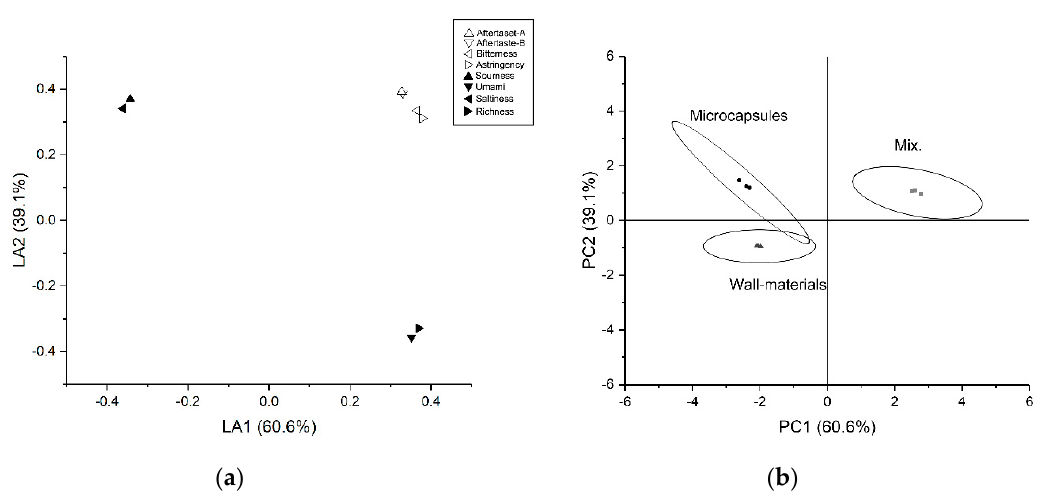
Figure 8. LA and PCA results for the electronic tongue: ( a ) LA and ( b ) PCA.